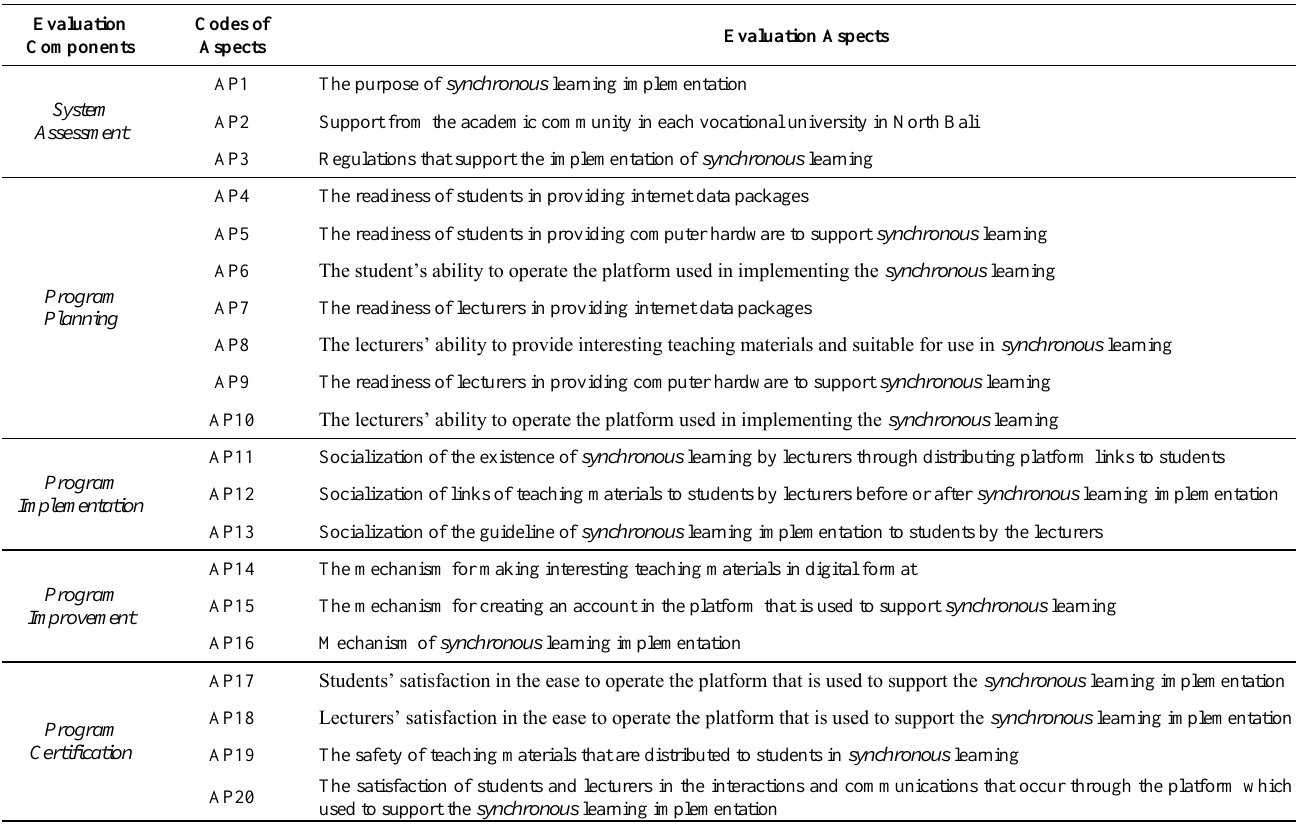
Table 1. Components and Aspects of the CSE-UCLA Evaluation Model as References for Evaluating the Implementation of Synchronous Learning at Vocational Universities in North Bali.